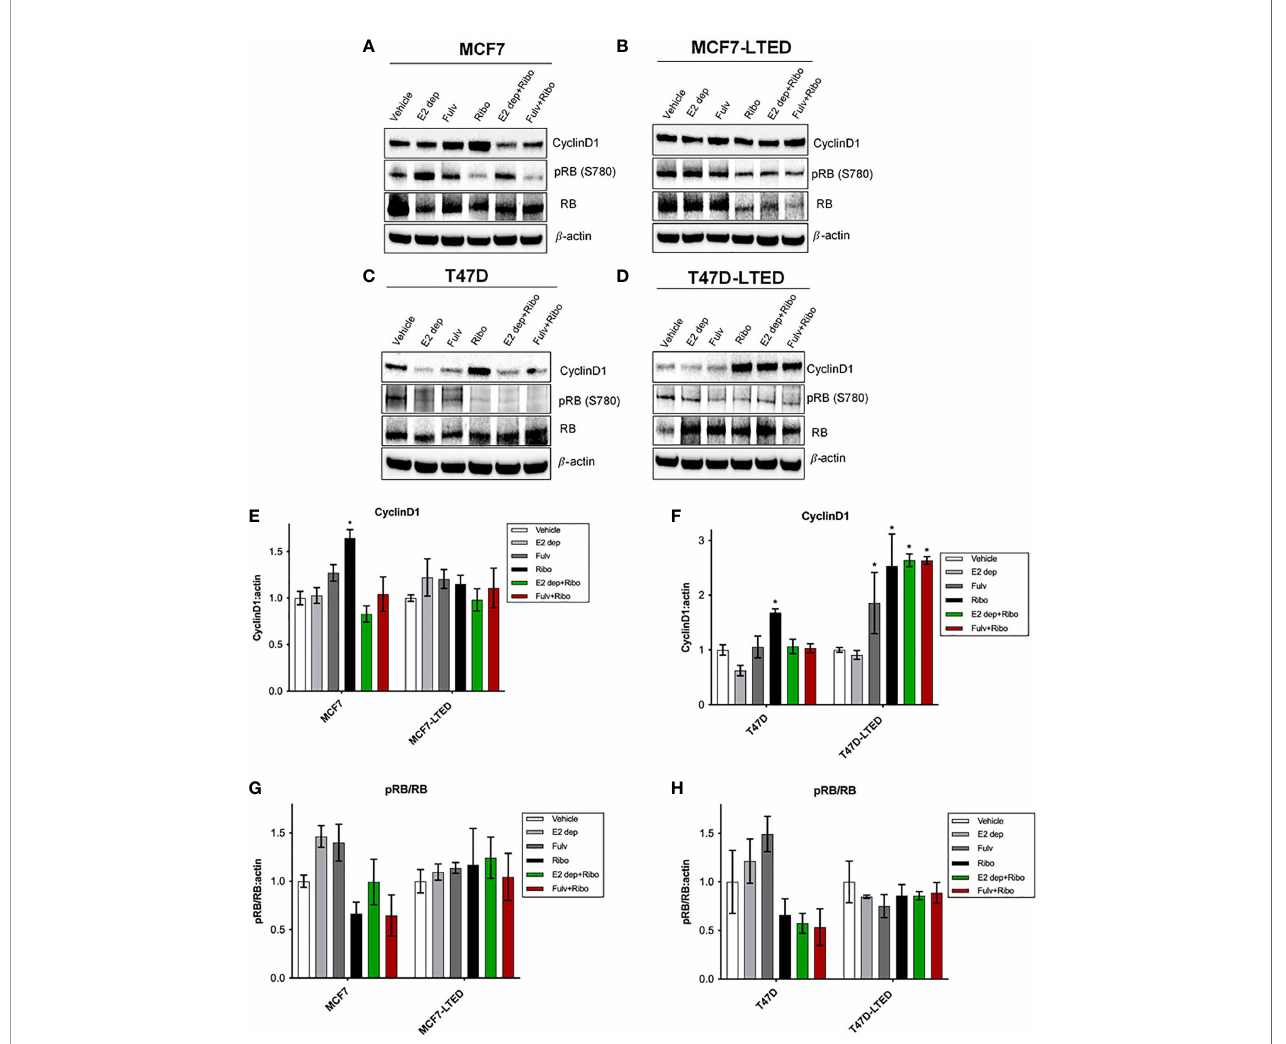
FIGURE 4 | Differential levels of CyclinD1 and pRB(780) proteins in paternal and LTED breast cancer cells treated with combination of E2 deprivation and ribociclib. (A, C) Parental MCF7 and T47D and their derivative, (B, D) MCF7-LTED and T47D-LTED were treated with vehicle, E2 deprivation (E2 dep), 100nM fulvestrant (Fulv), 500nM ribociclib (Ribo) or the combination of E2 dep and ribo or fulvestrant and ribo. Total cell lysates were collected at 12 days and subjected to immunoblotting with indicated antibodies. Bar graphs show relative mean values of proteins levels + SE for cyclin D1 (E, F) and ratio of pRB(780) to total RB (G, H) following treatments compared with vehicle control for respective cell lines. Protein bands from immunoblots were measured and normalized to actin (loading control) from three independent (n=3) experiments using ImageJ software. *p < 0.05 (ANOVA) for respective protein levels for indicated conditions compared with corresponding vehicle